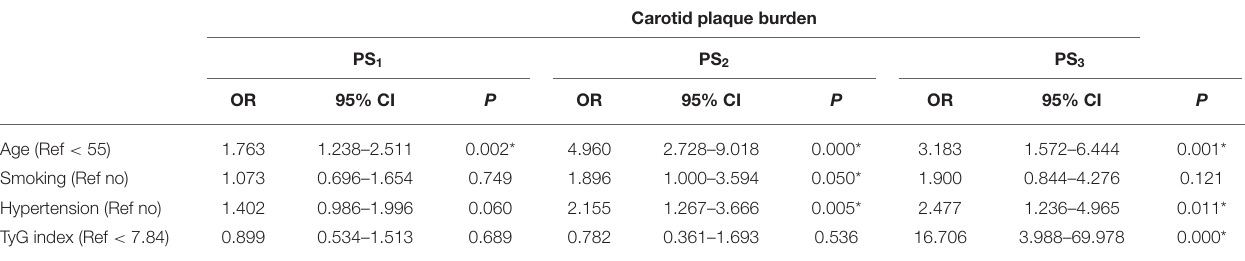
TABLE 3 | Multiclassification logistic regression